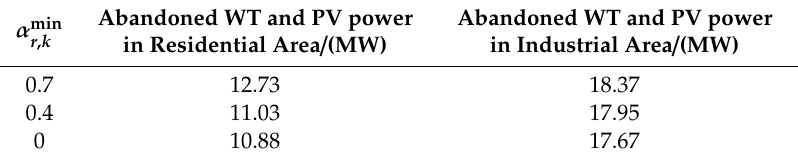
Table 6. Abandoned WT and PV power in functional areas under di ff erent charging coe ffi cients. Abandoned WT and PV power α min r , k in Residential Area /